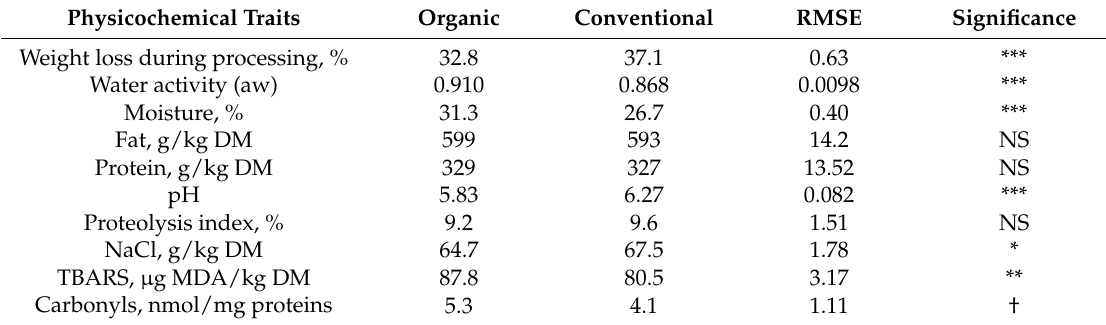
Table 1. Physicochemical traits of dry-fermented sausages (six per treatment group) manufactured without nitrite addition from pigs fattened in conventional or organic system. Physicochemical Traits Organic Conventional RMSE Significance Weight loss during processing, %